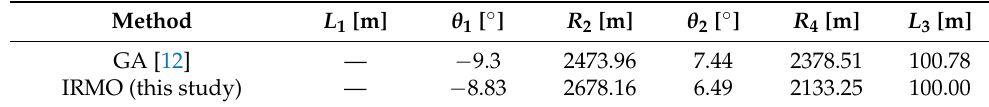
Table 4. Comparison of parameter optimization results.